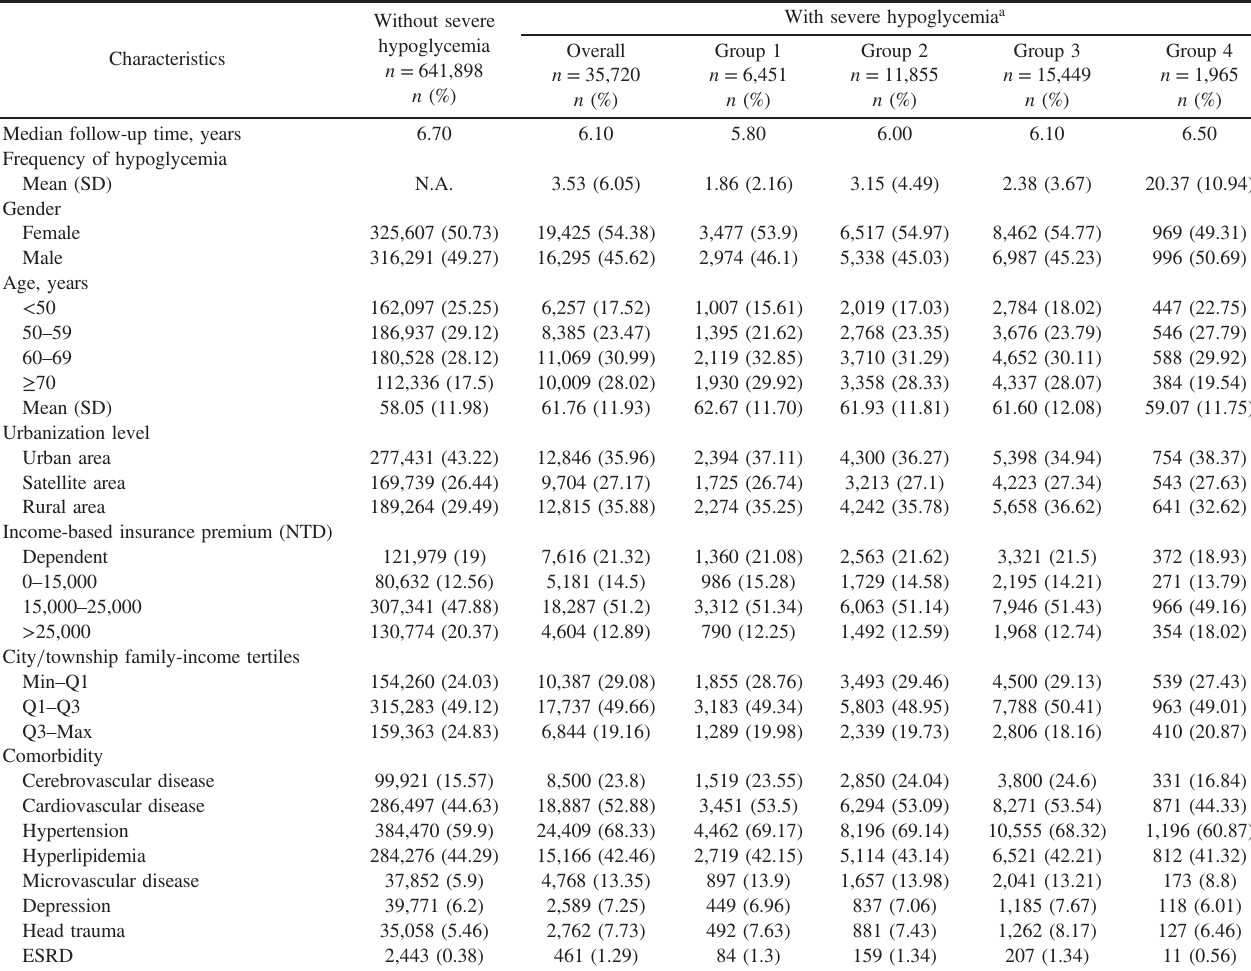
Table 1. Characteristics of study diabetes population according to severe hypoglycemia status